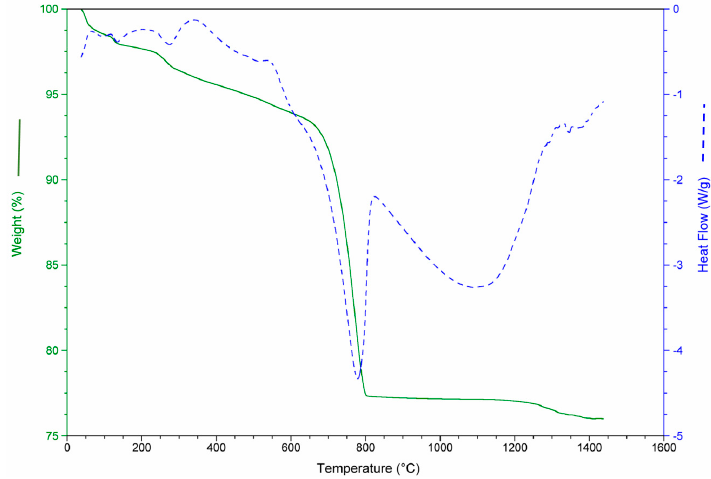
Figure 6. Mass loss and heat flow of the waste mixture (WM).